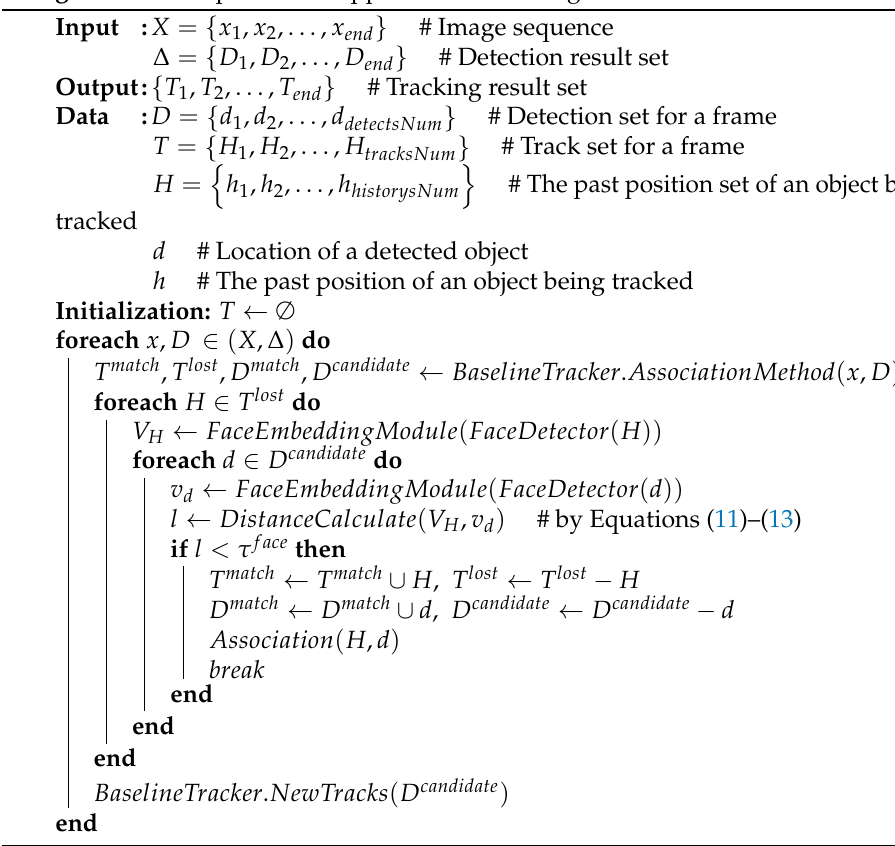
Algorithm 1: Proposed face appearance model